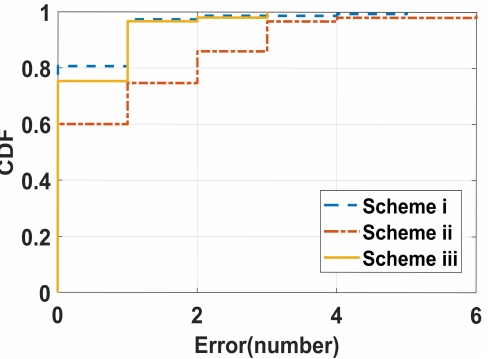
Figure 11. CDF of the counting error with various rope jumping